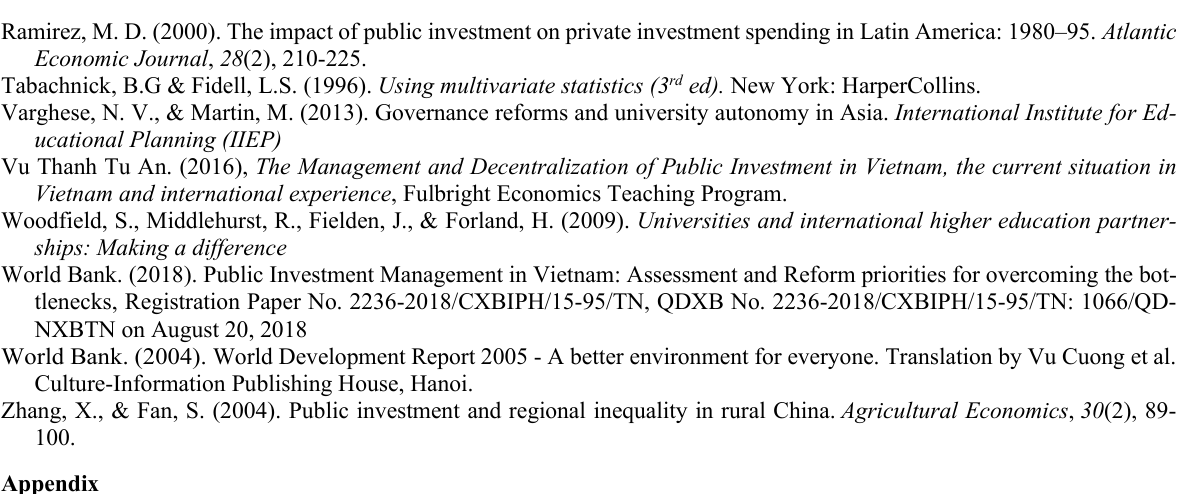
Description of the scales of the research model Symbol Scale / Variables The basis for variable selection The dependent variable